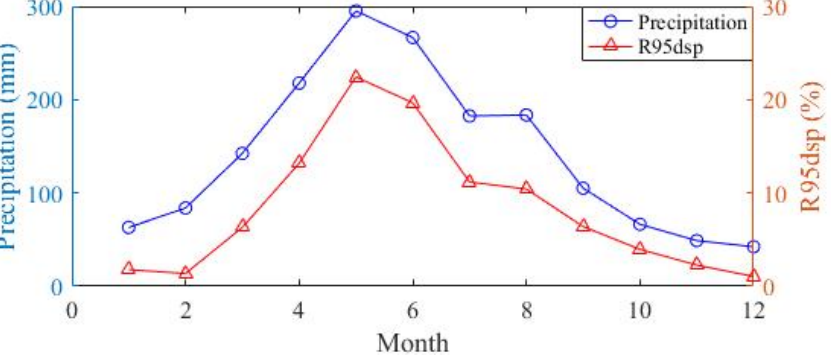
Figure 6. Annual distribution of R95ds and monthly precipitation in Beijiang River Basin from 1959 to 2018.